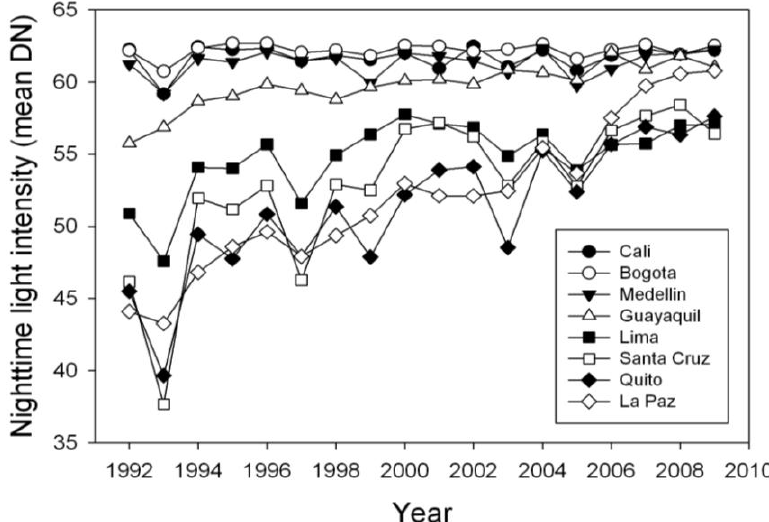
Figure 3. Time series analysis of the average light intensity or DN value per city between 1992 and